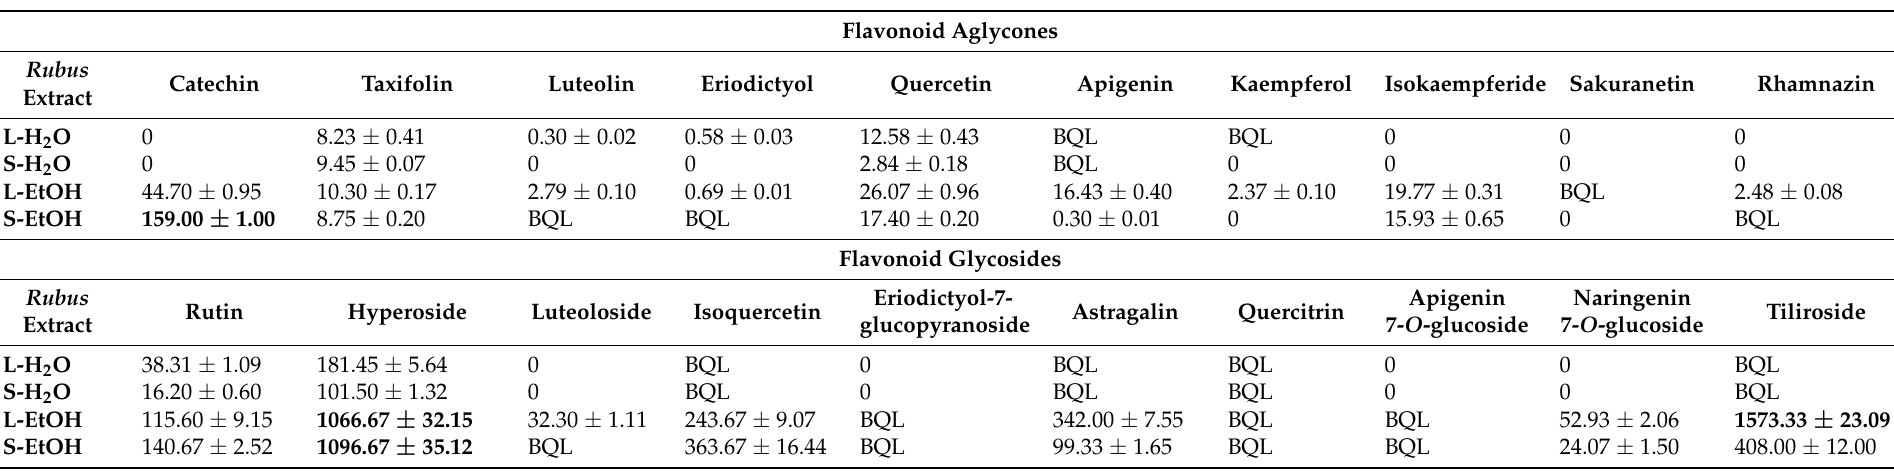
Table 3. Content (ng/mg of dry extract) of flavonoid aglycones and flavonoid glycosides detected in extracts from Rubus caesius leaves (L-H 2 O, L-EtOH) and